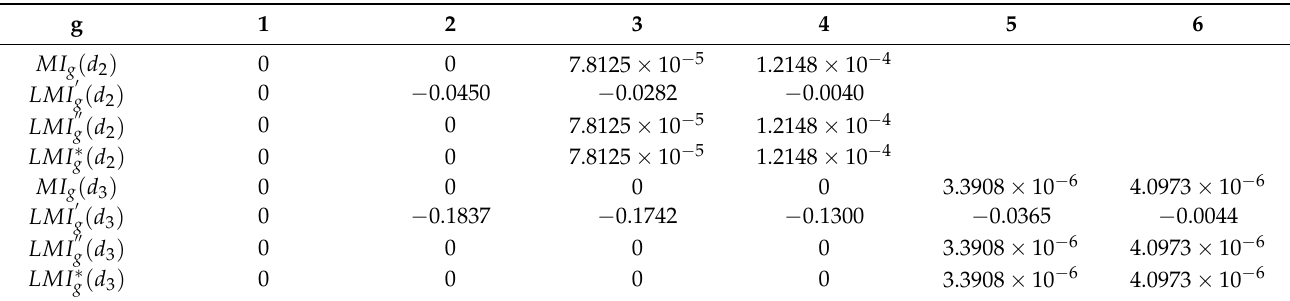
Table 2. Numerical results of designs d 2 and d 3